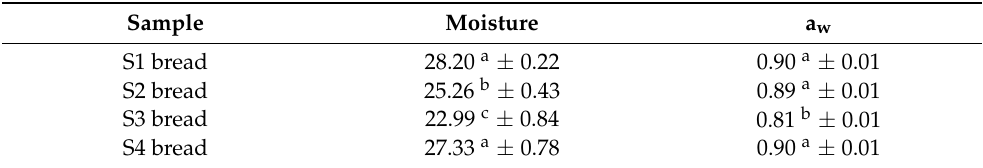
Table 3. Moisture (%) and water activity (a w ) of bread obtained from different sourdoughs (S1, S2, S3, and S4).